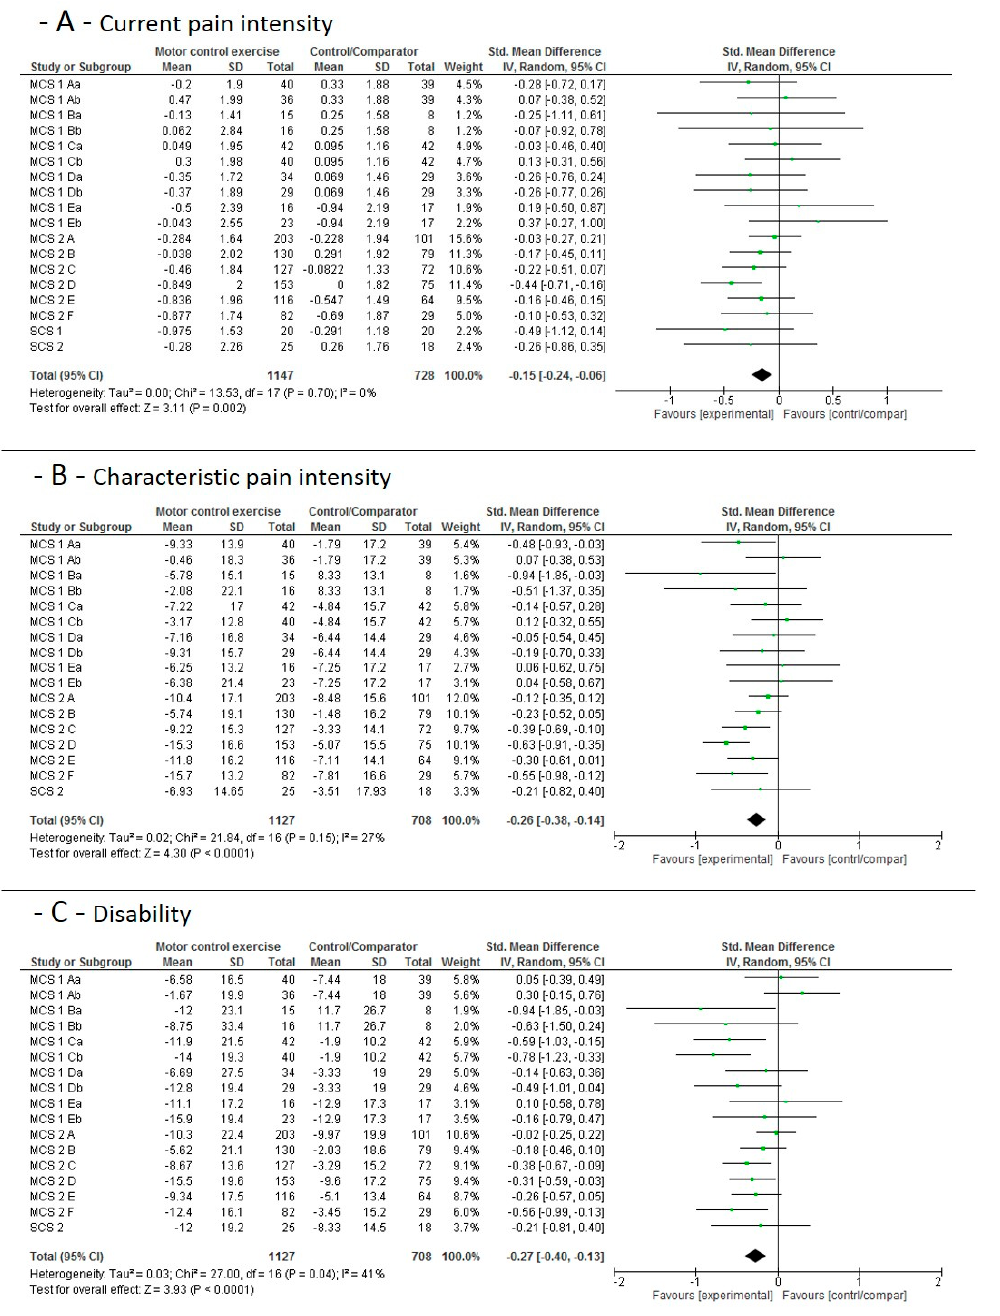
Figure 3. Data and Forest plots for the pooled outcome estimates for the mid-term e ff ects of motor control stabilisation exercise vs. no additional exercise. ( A ): current pain intensity; ( B ): characteristic pain intensity; ( C ): disability; MCS equals multicenter study; SCS equals single-center study, A–F are the single study sites; a stands for MCE, b for MCE + behavioral. SD, standard deviation; P, p -value; IV, inverse variance; CI, confidence intervals; experimental, motor control stabilisation group.